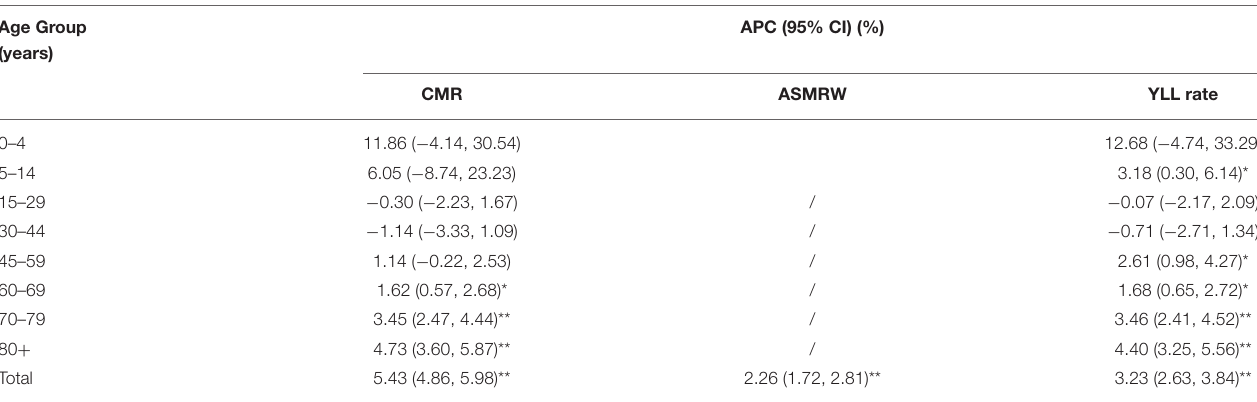
TABLE 4 | Trends of CMR, ASMRW, and YLL rate of selected neurological disorders in different age groups during 1995–2018. Age